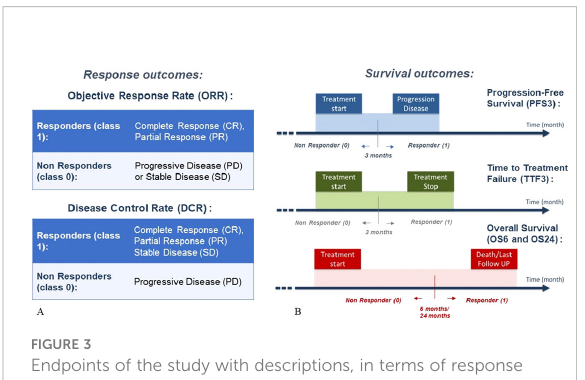
FIGURE 3 Endpoints of the study with descriptions, in terms of response outcomes (A) and survival outcomes (B)